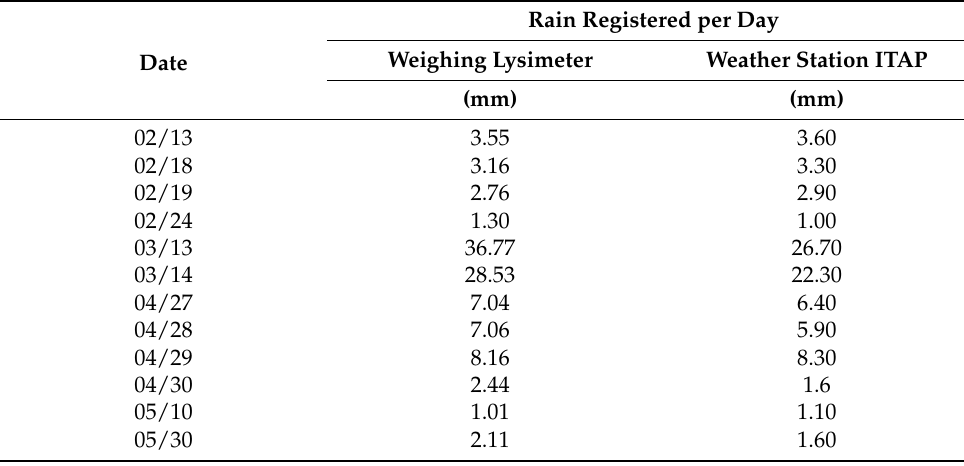
Table 1. Rainfall intensity data of the analyzed days recorded by two different